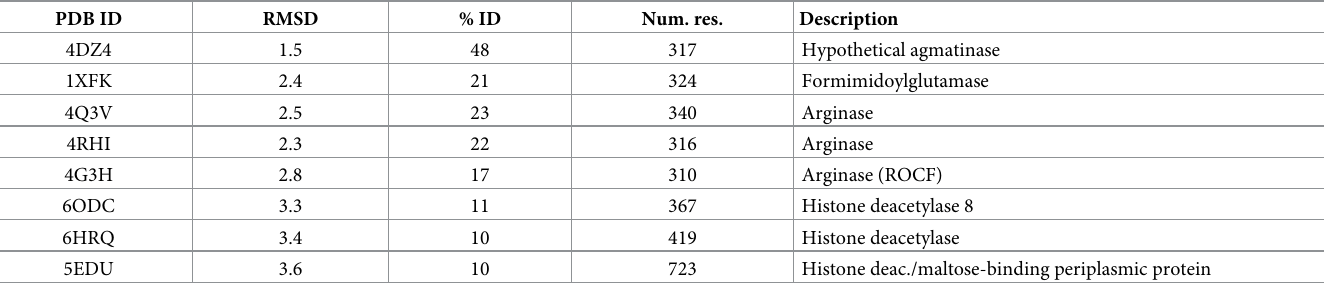
Table 2. Dali protein structure comparison results (protein matches to PDB25 with > 10% identity). PDB ID